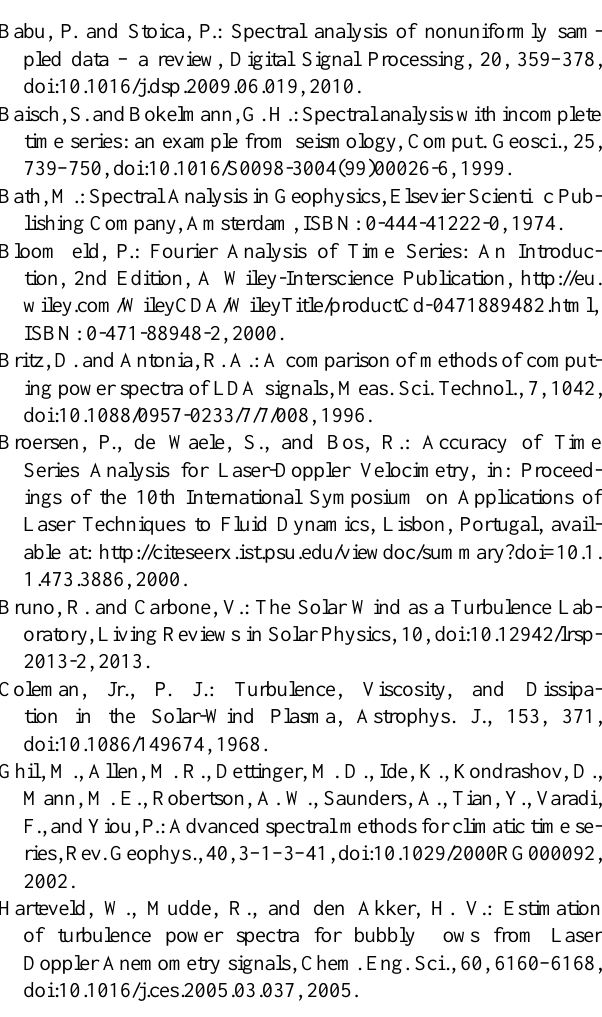
Table 1. Summary of the results of the comparative numerical studies with various types of gaps applied to synthetic and real data from the Venus Express satellite, respectively. Data set Single large gap Multiple small gaps FFT shows decreased amplitudes and Synthetic FFT and DFT show monotonically de- a systematic frequency dependence in creasing amplitudes of the sinusoidal amplitude reduction, with high frequen- modes, with increasing TGP. ZTR and cies being most affected. DFT, ZTR LST show neither decrease in the am- and LST recover the amplitudes of plitude of the sinusoidal modes nor fre- the sinusoidal modes, but the spec- quency dependence, when the TGP is tral background becomes increasingly increased. noisy when increasing the TGP. FFT shows a decrease in amplitudes Venus Express FFT and DFT show a decrease in the and a frequency dependence. DFT, ZTR average level of the spectrum when we and LST overestimate the high fre- increase the TGP. ZTR and LST show quency part of the amplitude an overall increase of the average level of the spectrum as TGP increases.